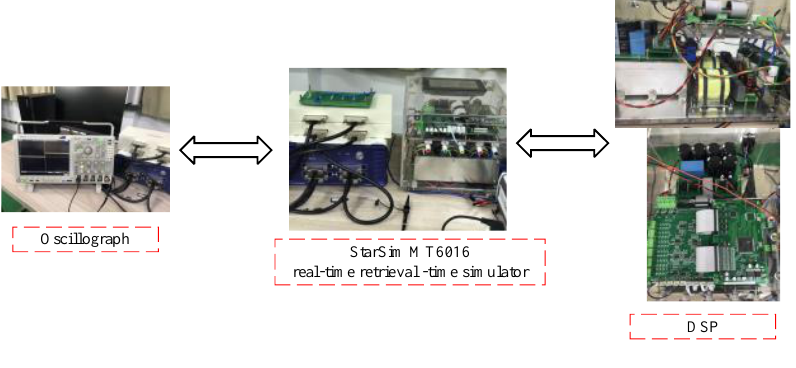
Figure 11. System Physical Diagram.